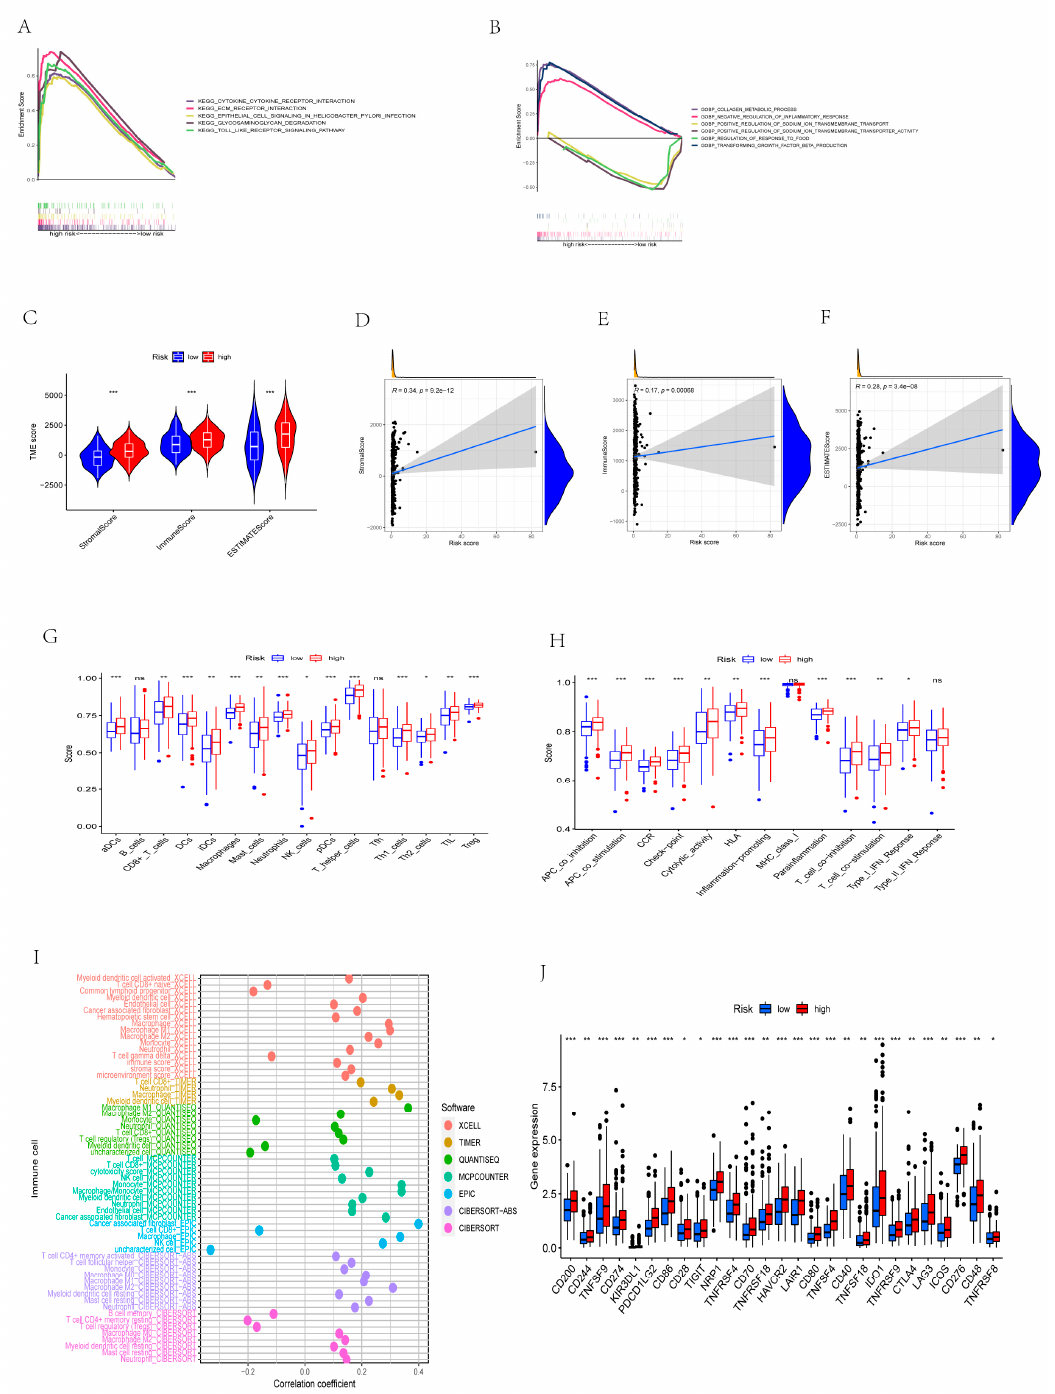
Figure 9. GSEA, TME, immune cell infiltration, and immune checkpoint identification of risk score. ( A ) KEGG enrichment in high-risk populations. ( B ) GO enrichment of different risk groups. ( C ) The situation of different risk groups in TME. ( D – F ) Correlation analysis between risk score and Stroma- lScore, ImmuneScore, and ESTIMATEScore. ( G ) Expression of immune cells in different risk groups (ns represent nonsense). ( H ) Different cell functions in different risk groups (ns represent nonsense). ( I ) Correlation analysis of immune cells and risk scores in different algorithms. ( J ) Expression of immune checkpoints in different risk groups. (* p < 0.05, ** p < 0.01, *** p <